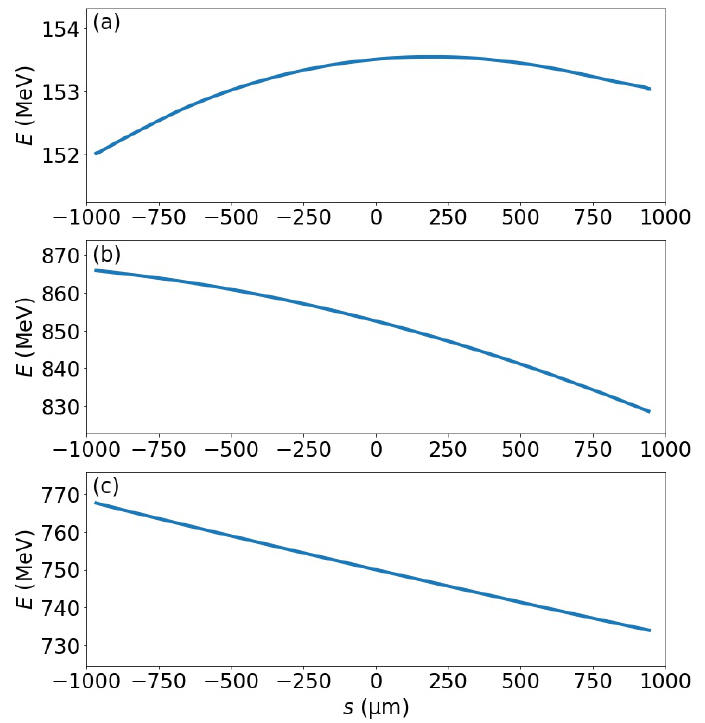
Figure 10. The evolution of the longitudinal energy distribution within the beam from ( a ) the photoinjector exit, ( b ) at the end of the linear accelerator section, and ( c ) at the end of the linearizer section. The final form of the longitudinal energy distribution within the beam is the chirp that is used in